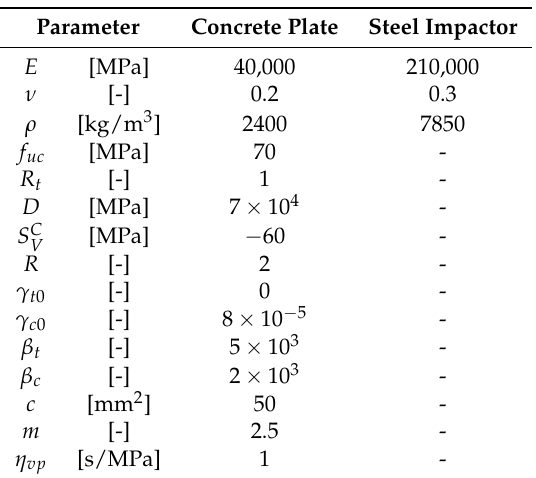
Figure 14. Finite element mesh of thick plate impact test: ( a ) geometry and ( b ) dimension of the steel impactor. Table 2. Material properties for the thick plate impact